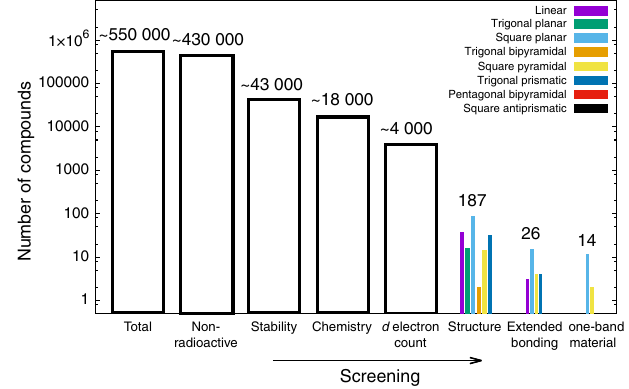
FIG. 1. Materials database screening for correlated one-band materials. The decrease in the number of compounds, on a logarithmic scale, is shown as additional screening criteria are applied from left to